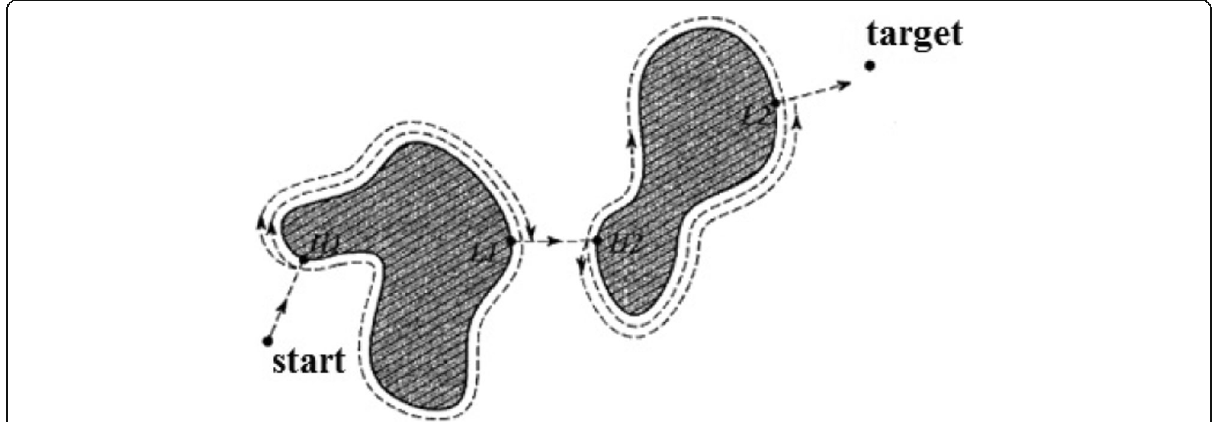
Fig. 1 Bug1 algorithm with two points H1 and H2 as collision points. L1 and L2 are selected as the exit point